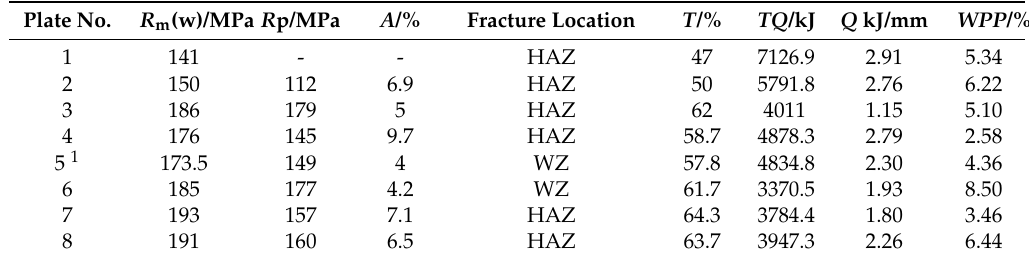
Table 4. Tensile properties of butt welded joints as a result of heat